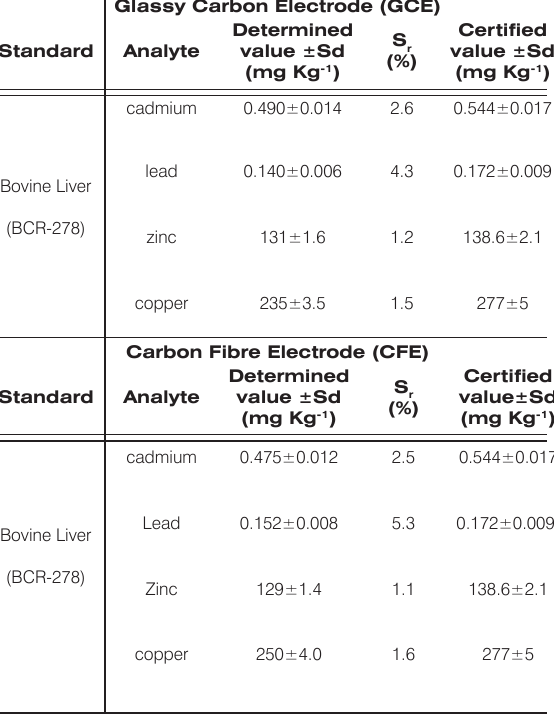
Glassy Carbon Electrode